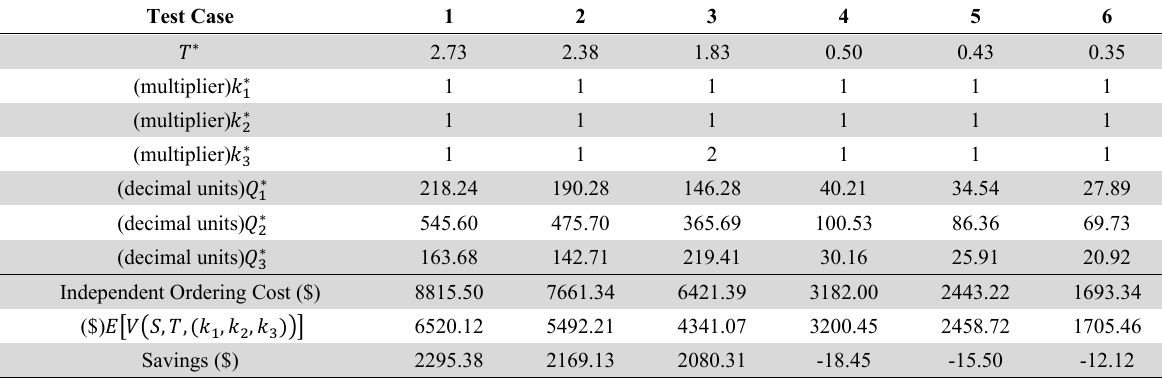
Results of the first group of test